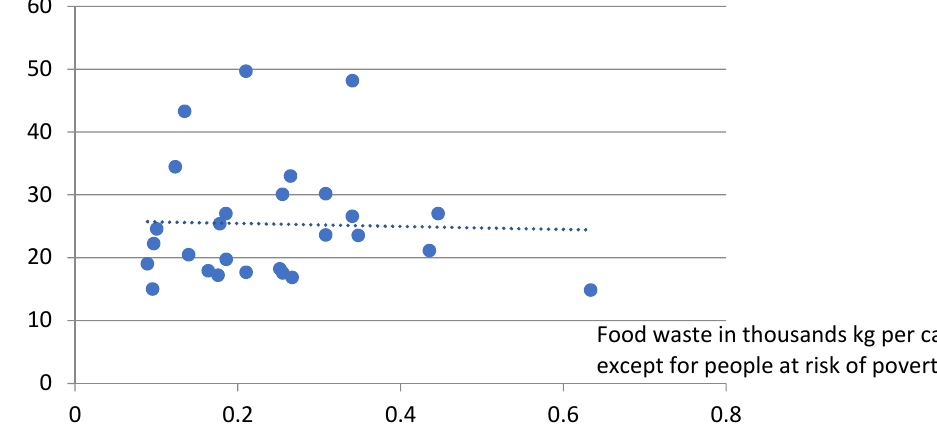
Figure 6. Relationship between the amount of food waste per capita, excluding people at risk of poverty, and the percentage of the population at risk of poverty. Source: created by authors.